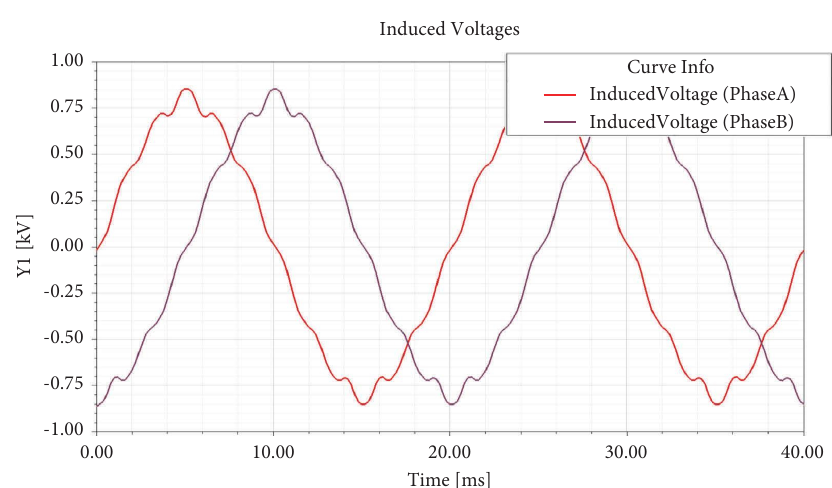
Figure 32: Back EMF curve of pear-shaped ladder slot